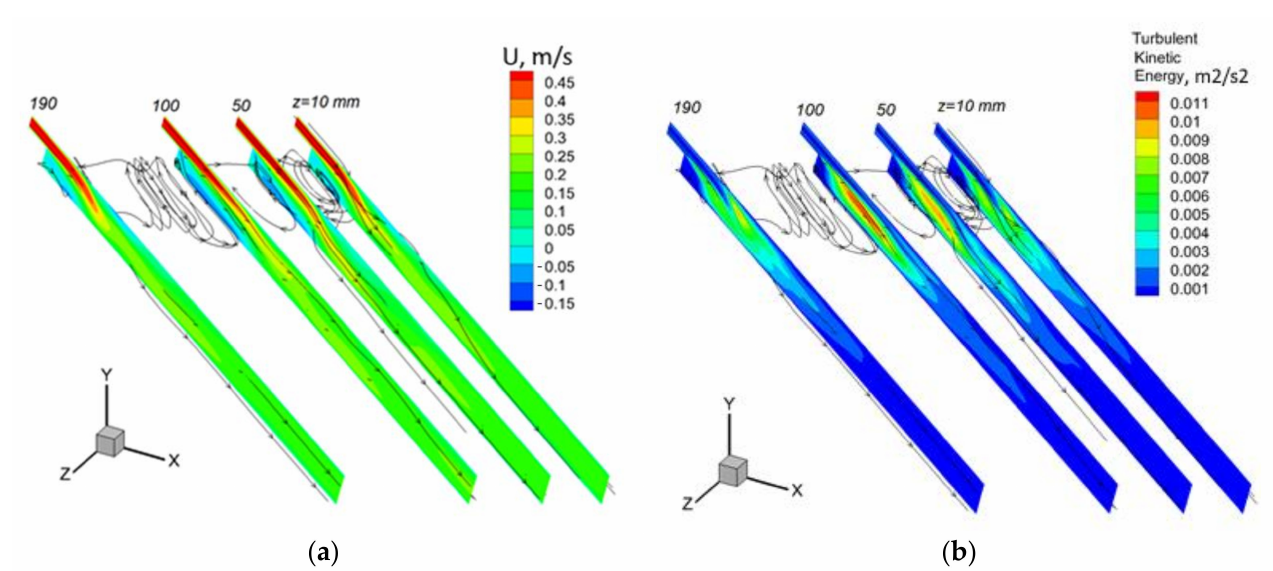
Figure 8. The 3D RANS + SST predicted contours of the longitudinal velocity component and streamlines ( a ) and turbulent kinetic energy ( b ) at the z = 10, 50, 100, 190 mm ( z / H = 0.8, 4.2, 8.3 and